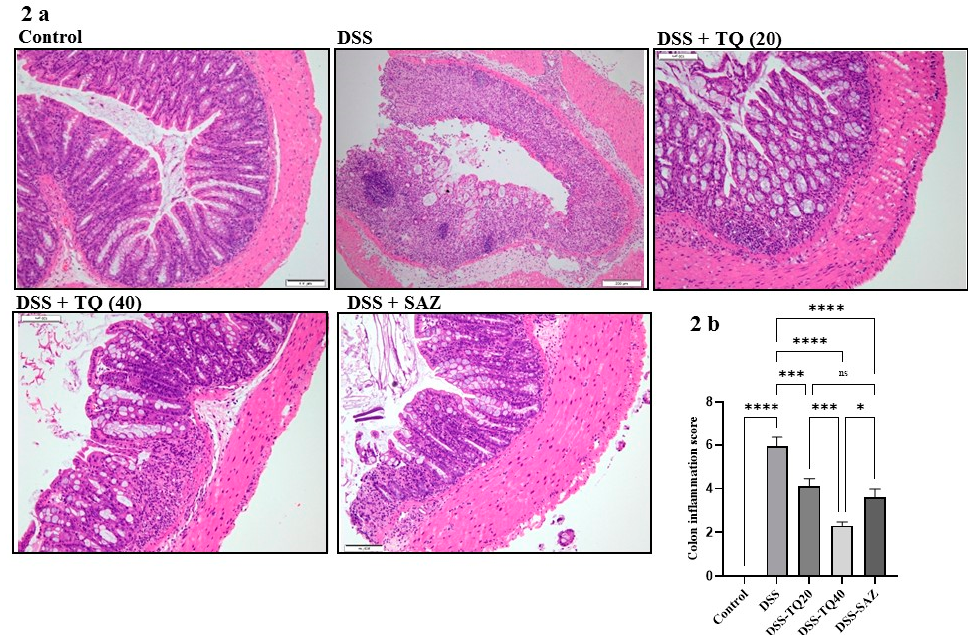
Figure 2. Effect of TQ on colon histology. ( a ) Histological examination shows typical colon architecture with normal thickness of submucosa, the muscle layer, and normal crypt and villi structure in control samples (scale bars: 100 μ M). The DSS-administered colitis section shows loss of crypts and surface epithelium. The inflammation reaches the submucosa. TQ and SAZ treatment protected the microscopic architecture in the DSS-treated colitis group. ( b ) TQ treatment significantly reduced colon inflammation score. n = 8 animals used in each group to obtain the data. The data expressed as means ± SEM. **** p < 0.0001, *** p < 0.001, ** p < 0.01 , and * p < 0.05 . (NS) not significant .